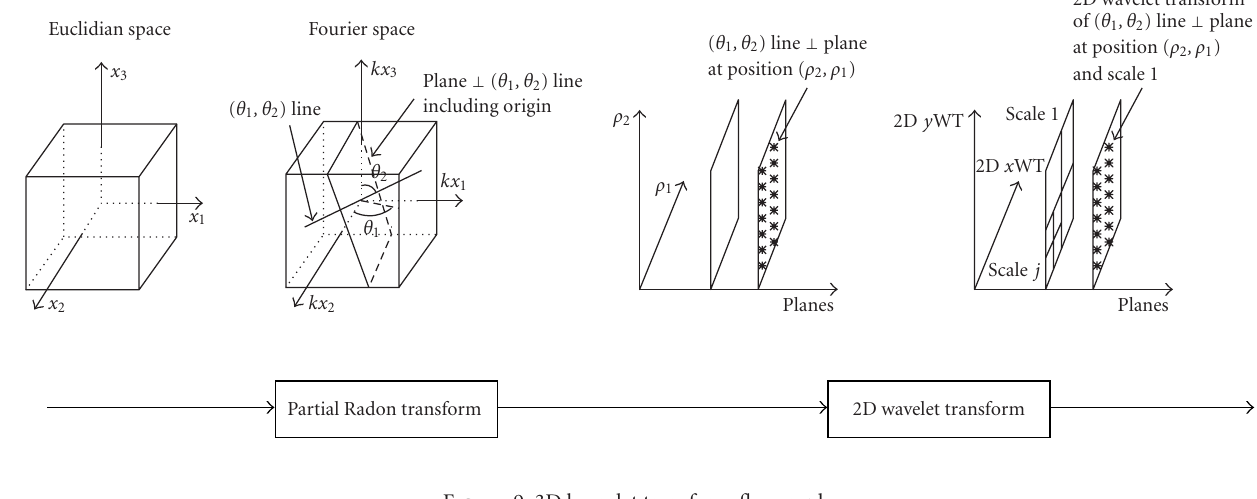
Figure 9: 3D beamlet transform